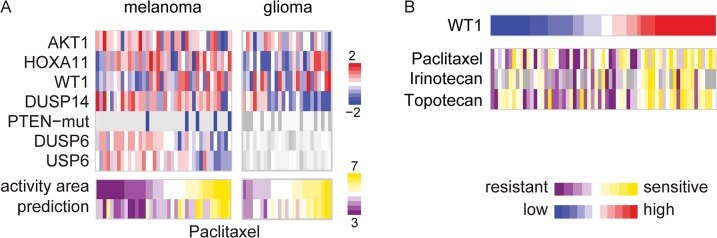
Example of predictive model for melanoma and glioma samples.A. CHER’s model for drug sensitivity to paclitaxel. Each vertical bar represents a data of a sample. All features are gene expression profiles except PTEN, which is a mutation profile feature (blue bars represents samples with mutations). AKT1 and WT1 are predictive for both melanoma and glioma. PTEN-mut, DUSP6 and USP6 are predictive features specific for melanoma whereas DUSP14 is specific for glioma. The greyed out heatmaps represents those features are not predictive for the samples. The predictions are obtained from leave-one-out procedure with the final selected features. B. Expression of WT1 is predictive of the cytotoxic drugs paclitaxel, irinotecan and topotecan, which likely due to IGF1-R activity.